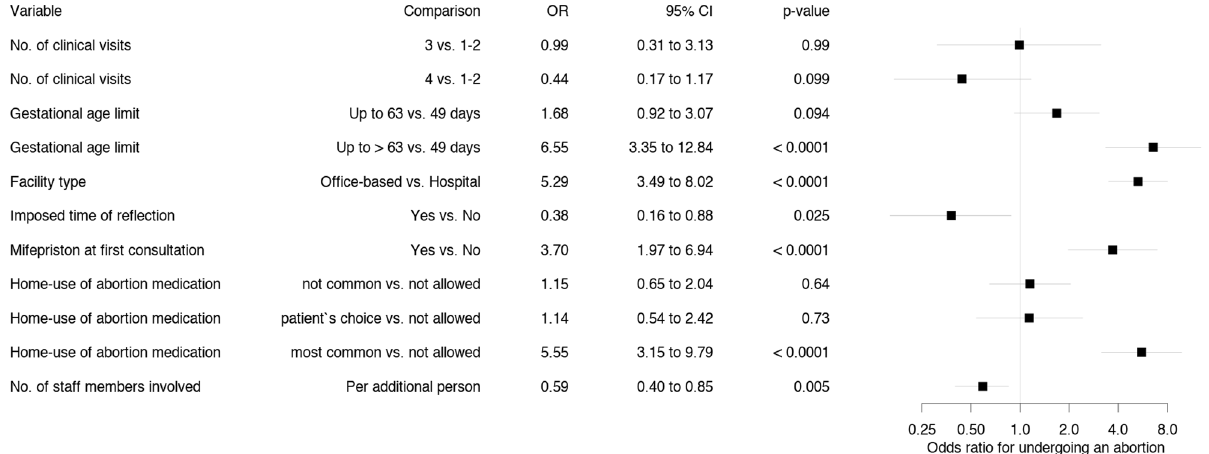
Figure 2. Association between protocol characteristics and the proportion of patients who followed through with the abortion at the same facility. Odds ratios were estimated by single variable GEE models (referred to as single-variable models in the text).